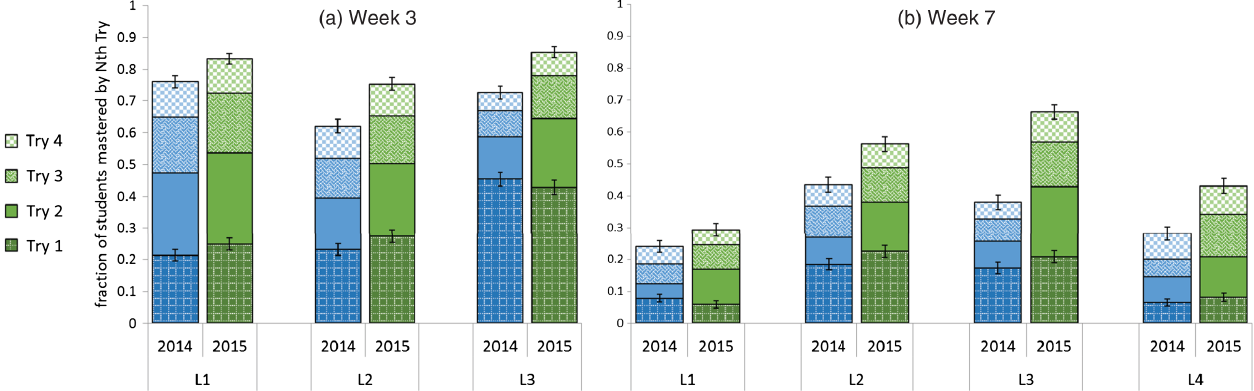
FIG. 5. Student progression through unchanged weeks ’ levels in 2014 and 2015, (a) week 3 and (b) week 7: Progression is shown as the fraction of students who had mastered each level by